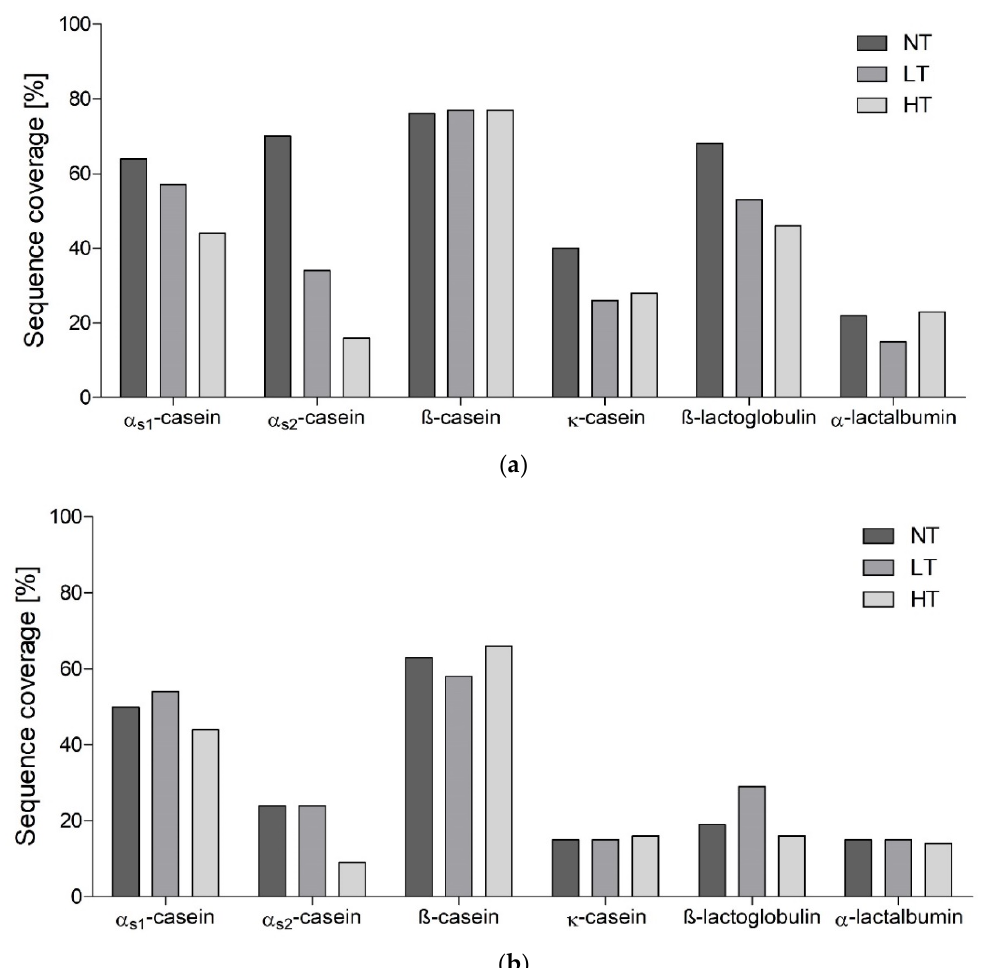
Figure 2. Sequence coverage of the six main milk proteins by digestion-derived peptides with and without posttranslational modification derived from in vitro digests of cow’s milk protein. Samples were non-treated (NT), heated at low temperature (LT), and heated at high temperature (HT) ( a ) after 10 min in the intestinal phase and ( b ) after 60 min in the intestinal phase.